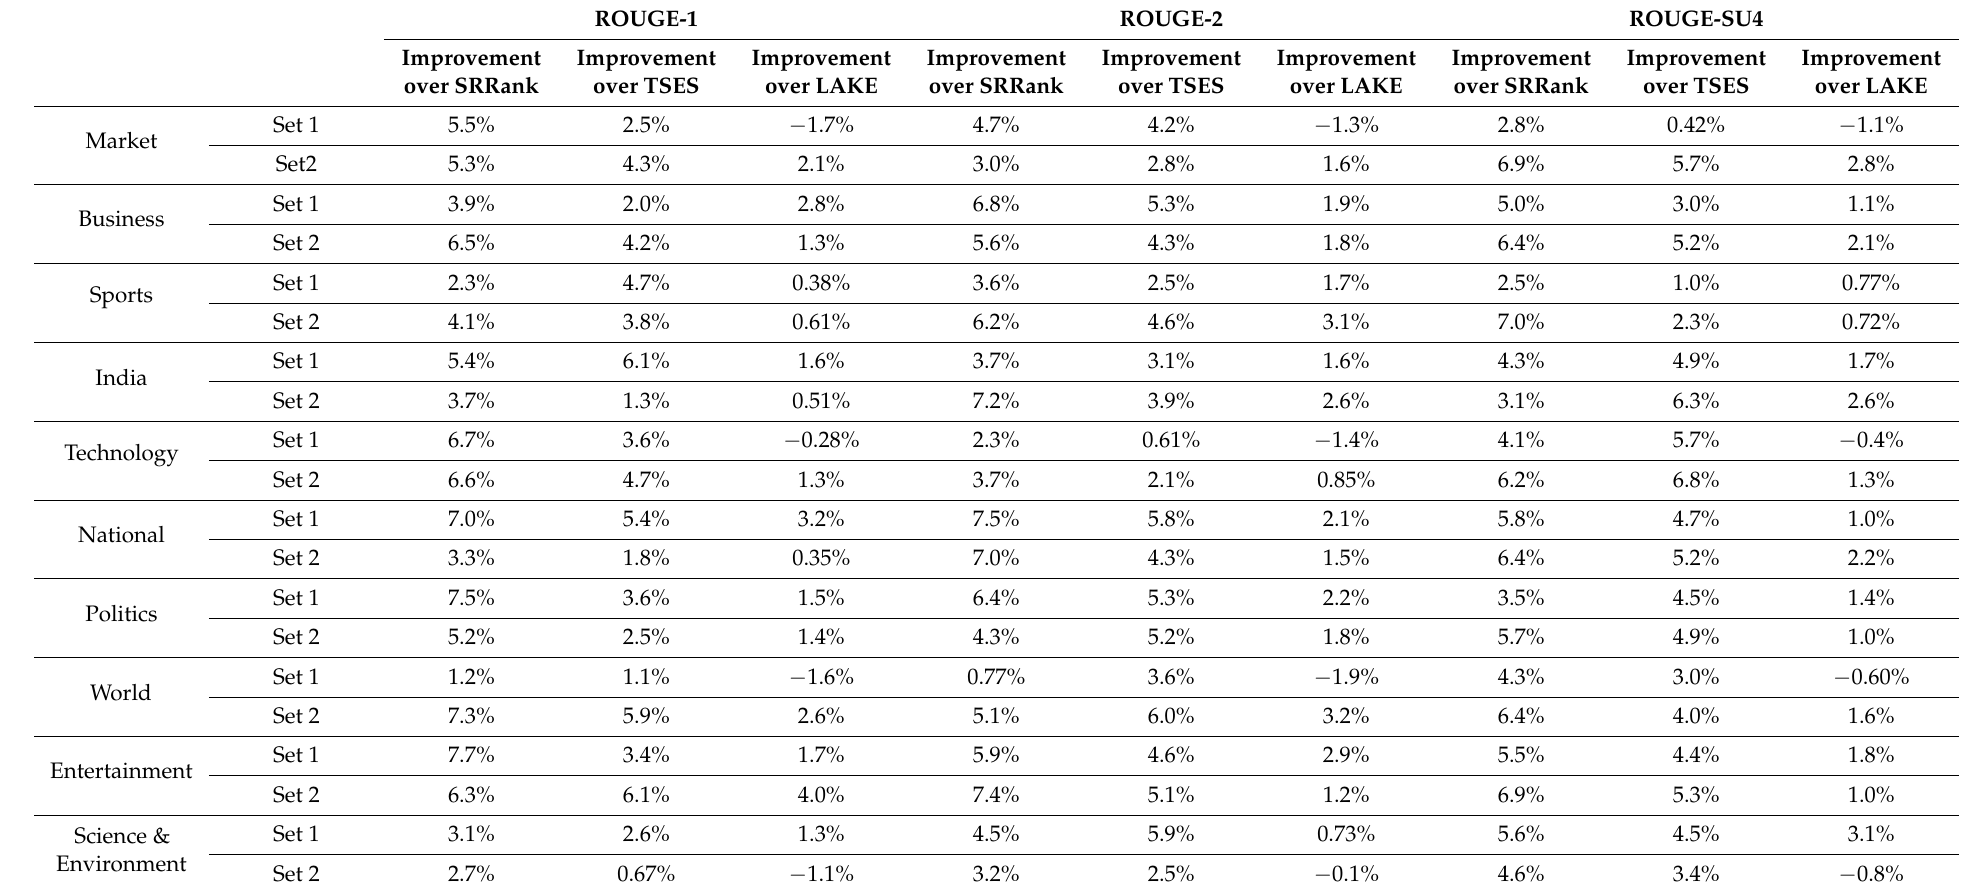
Table 8. Performance improvement of proposed approach over the baseline